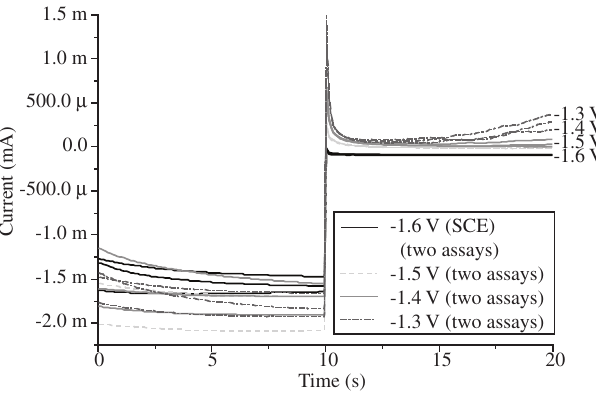
Figure 7. Transient currents corresponding to AZ31 magnesium alloy im- mersed in 10 g/L NaCl. Different records at -1.8 V are shown (left)